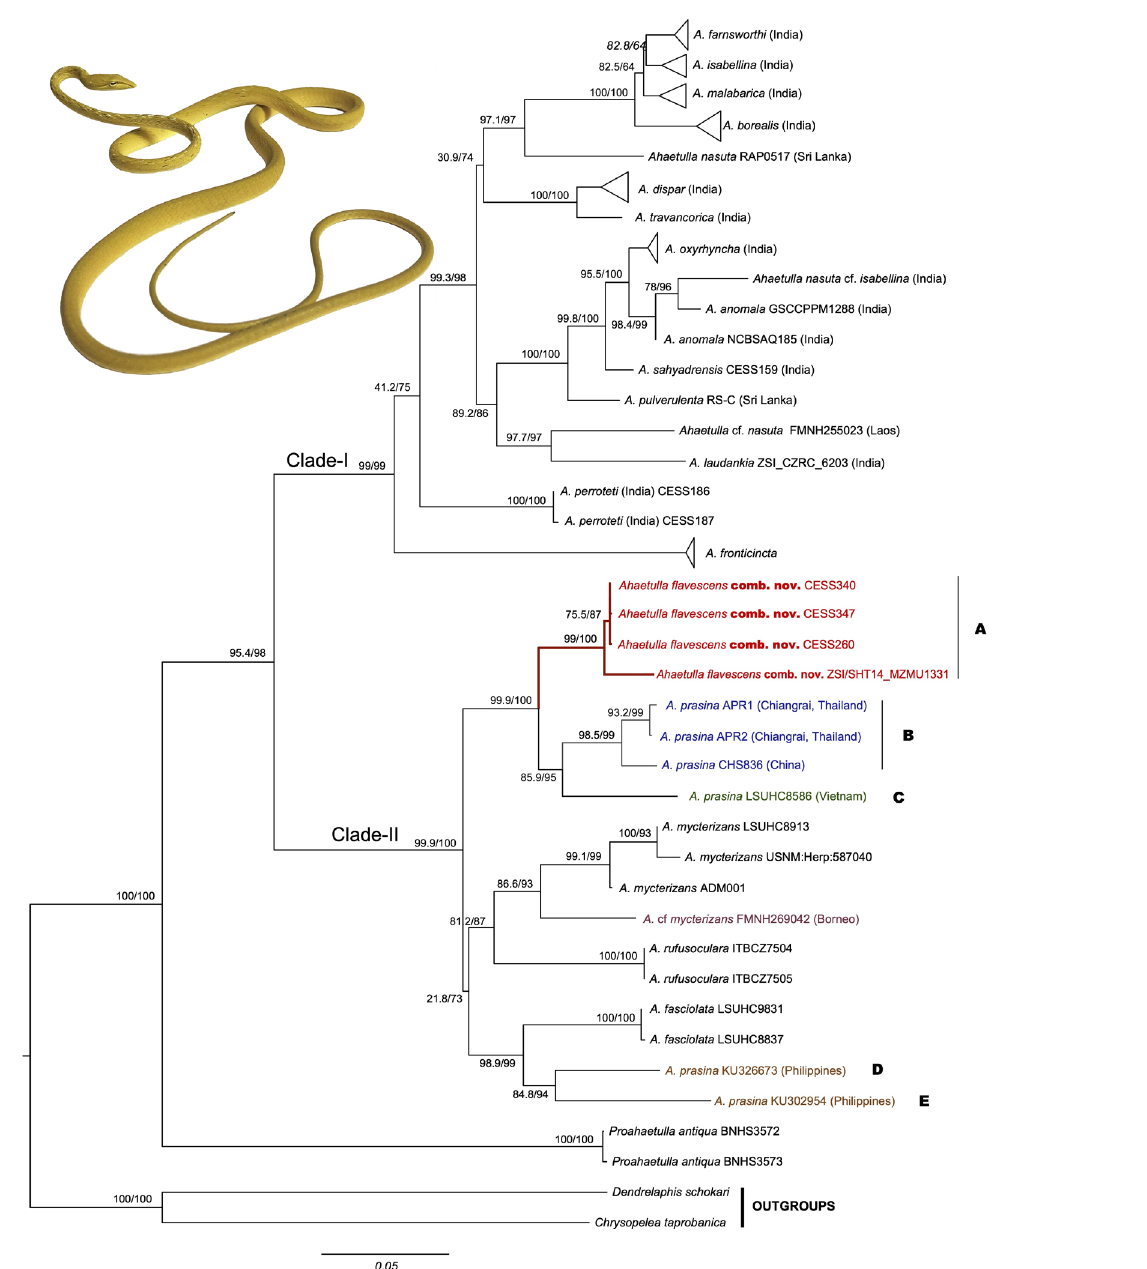
Fig. 1. Maximum Likelihood tree based on Cytb, ND4 and 16S genes, showing the phylogenetic position of Ahaetulla flavescens (Wall, 1910) comb. nov. (red), with respect to other congeners, especially the A. prasina complex (blue, green, purple and